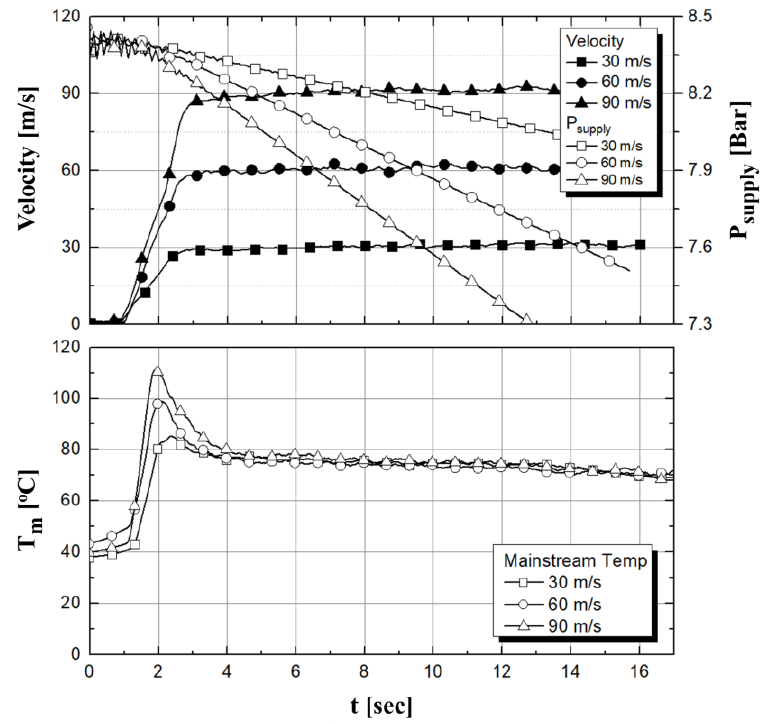
Figure 2. Mainstream velocity and temperature history during the